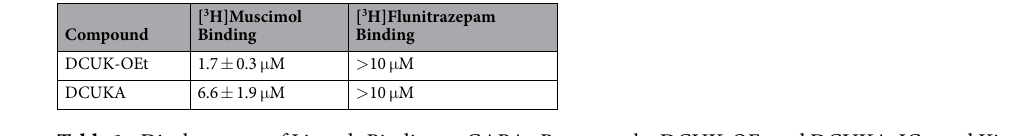
Table 1. Displacement of Ligands Binding to GABA A Receptors by DCUK-OEt and DCUKA. IC 50 and Ki values were obtained by non-linear regression analysis of radioligand binding isotherms. Ki values are reported as estimates from the non-linear regressions and their associated standard errors (n = 10 points in the binding isotherms).